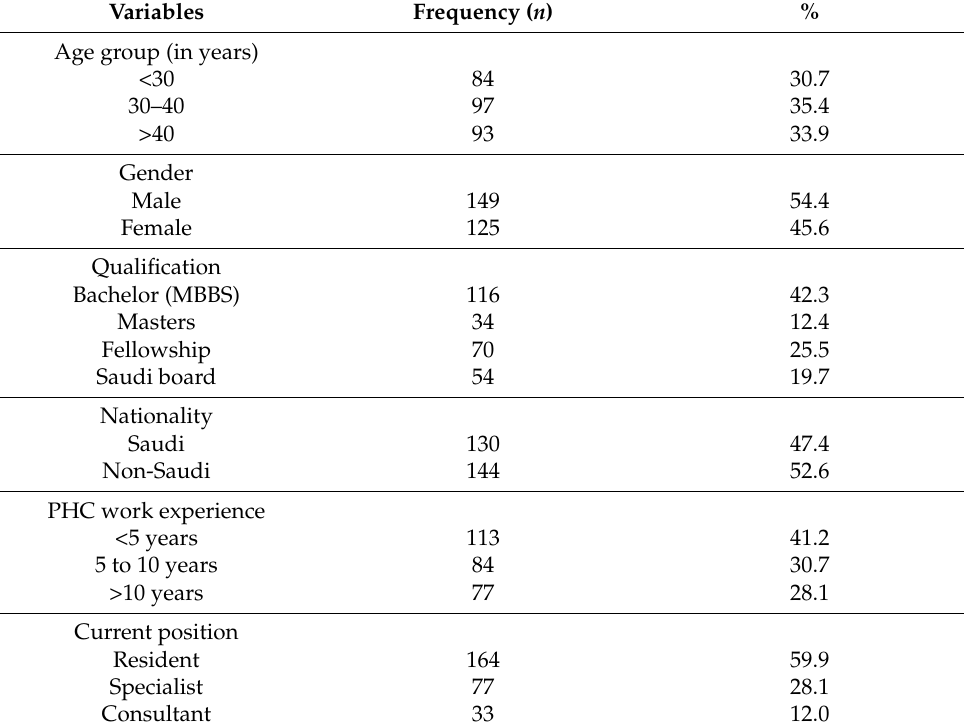
Table 1. Socio-demographic characteristics of the primary care physicians. The data presented here are frequency and percentage ( n , %), ( n =